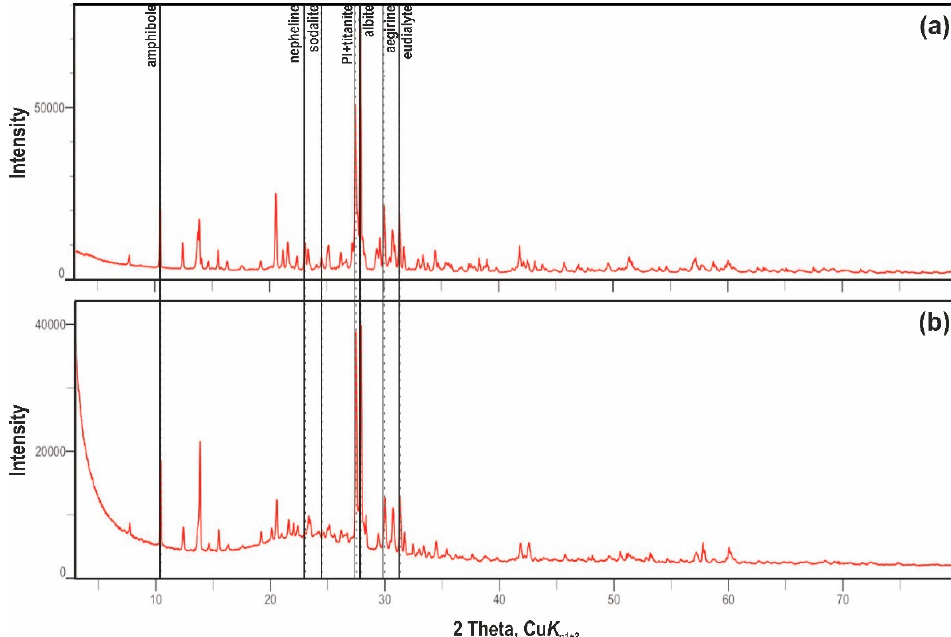
Figure 5. X-ray powder diffraction patterns of the eudialyte ore concentrate before (a) and after (b) breakdown.